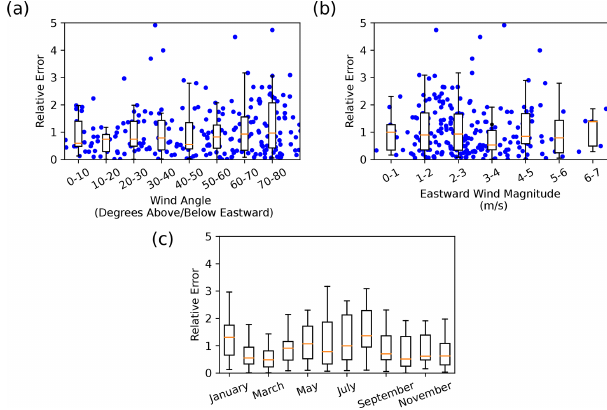
Figure 3. Performance of the XCO 2 -based CO 2 flux anomaly es- timation when varying the target domain area. (a) Domain loca- tions and sizes shown, where their domain border colors match the dot symbol colors in panels (b) – (d) . (b) Correlation, (c) root mean square error, and (d) bias between the CO 2 flux anomaly estima- tion with Eq. (1) based on XCO 2 from CarbonTracker and the Car- bonTracker monthly surface CO 2 flux anomaly outputs, which is considered here as the reference.